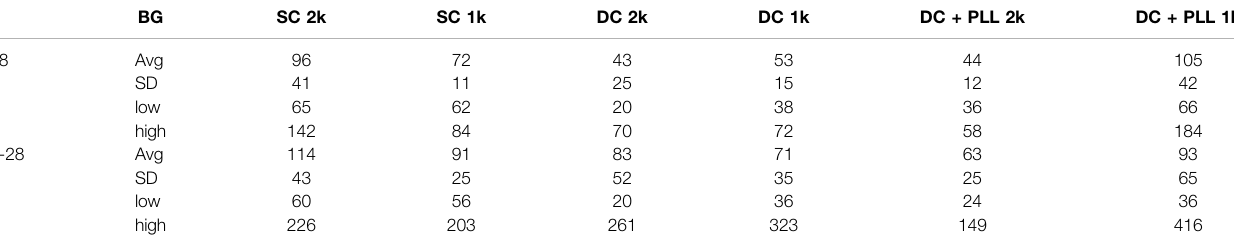
TABLE 2 | Blood glucose (BG) values at d28 and d3 – 28 of NOD-scid recipients of ALG microencapsulated human islets transplanted in the IP site. BG SC